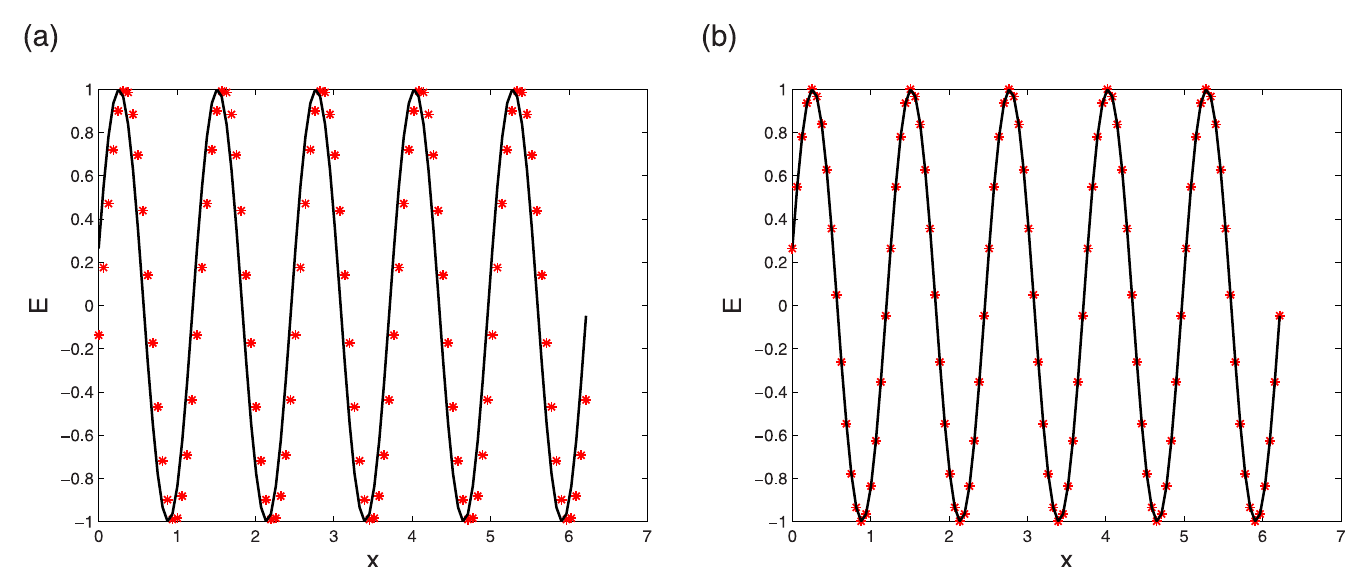
Fig 4. Waveform curves of exact solution (solid line), numerical solutions (star point) of central box scheme (left) and LODEFMS scheme (right) under second set of test data.